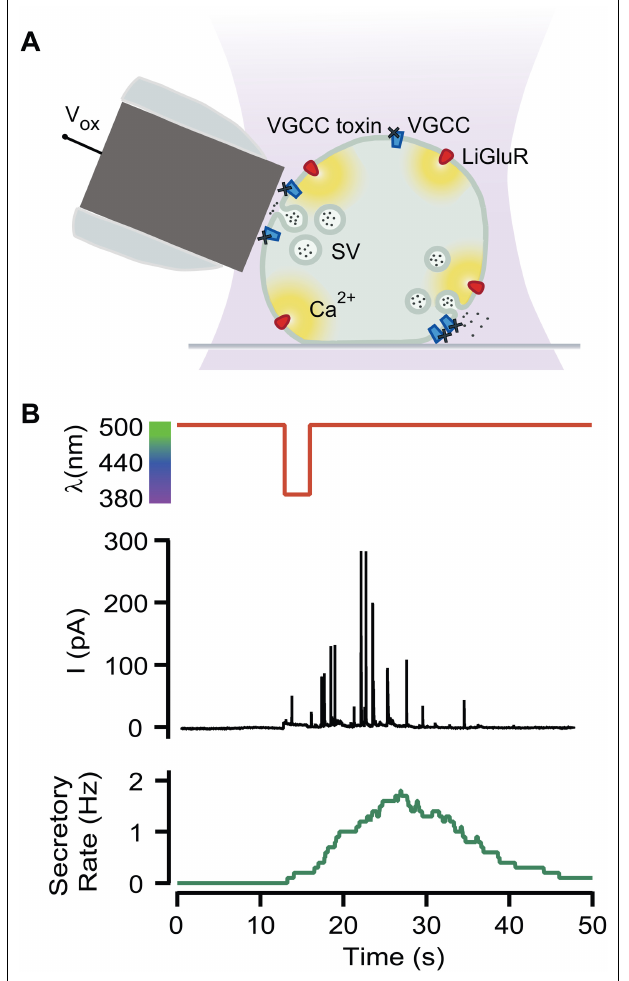
FIGURE 1 | Optical triggering of neurosecretion. (A) Diagram of the experimental approach. Secretion upon light stimuli was detected by amperometry in LiGluR( + ) chromaffin cells whileVGCC where blocked by toxins ( V ox , oxidation voltage; SV, secretory vesicle). (B) Amperometric current recording (black plot) from a single LiGluR( + ) cell in response to 5 s, 380 nm light pulse (red plot), and the secretory rate (green plot).